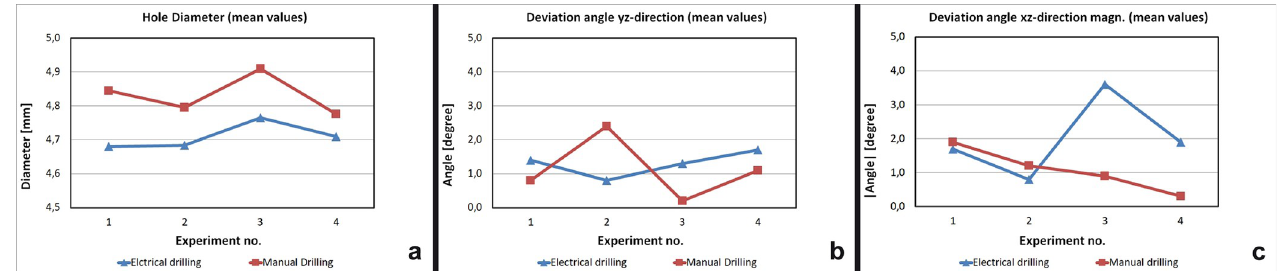
Fig 5. Borehole geometry. (A) Hole diameter (B) Deviation angle xy-direction (C) Deviation angle xz-direction.